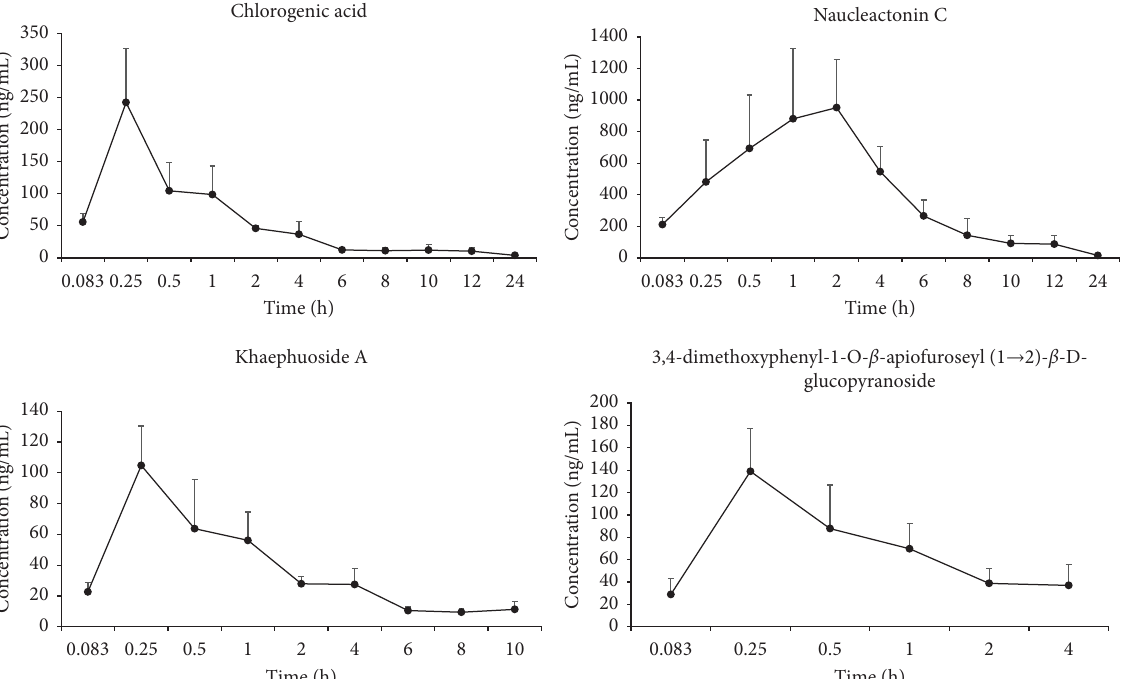
Figure 3: Concentration-time profles of four analytes in rat plasma following oral administration of Nauclea ofcinalis extracts at a dose of 2g/kg.